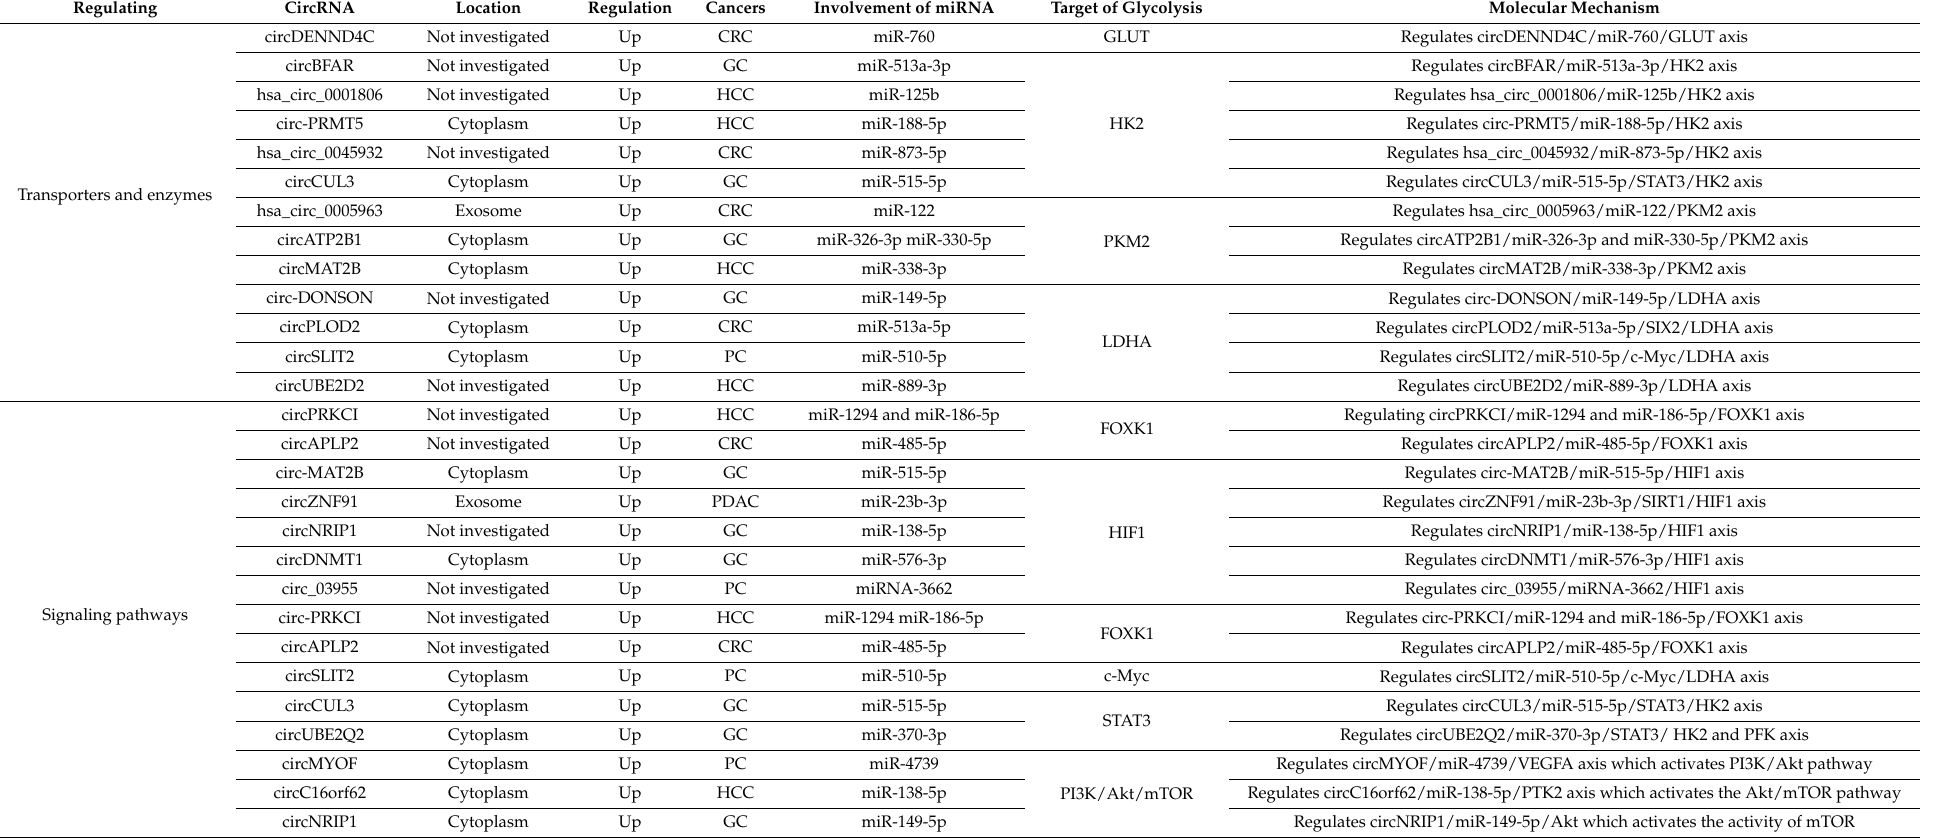
Table 1. The molecular mechanisms by which circRNAs regulate glucose metabolism in GI